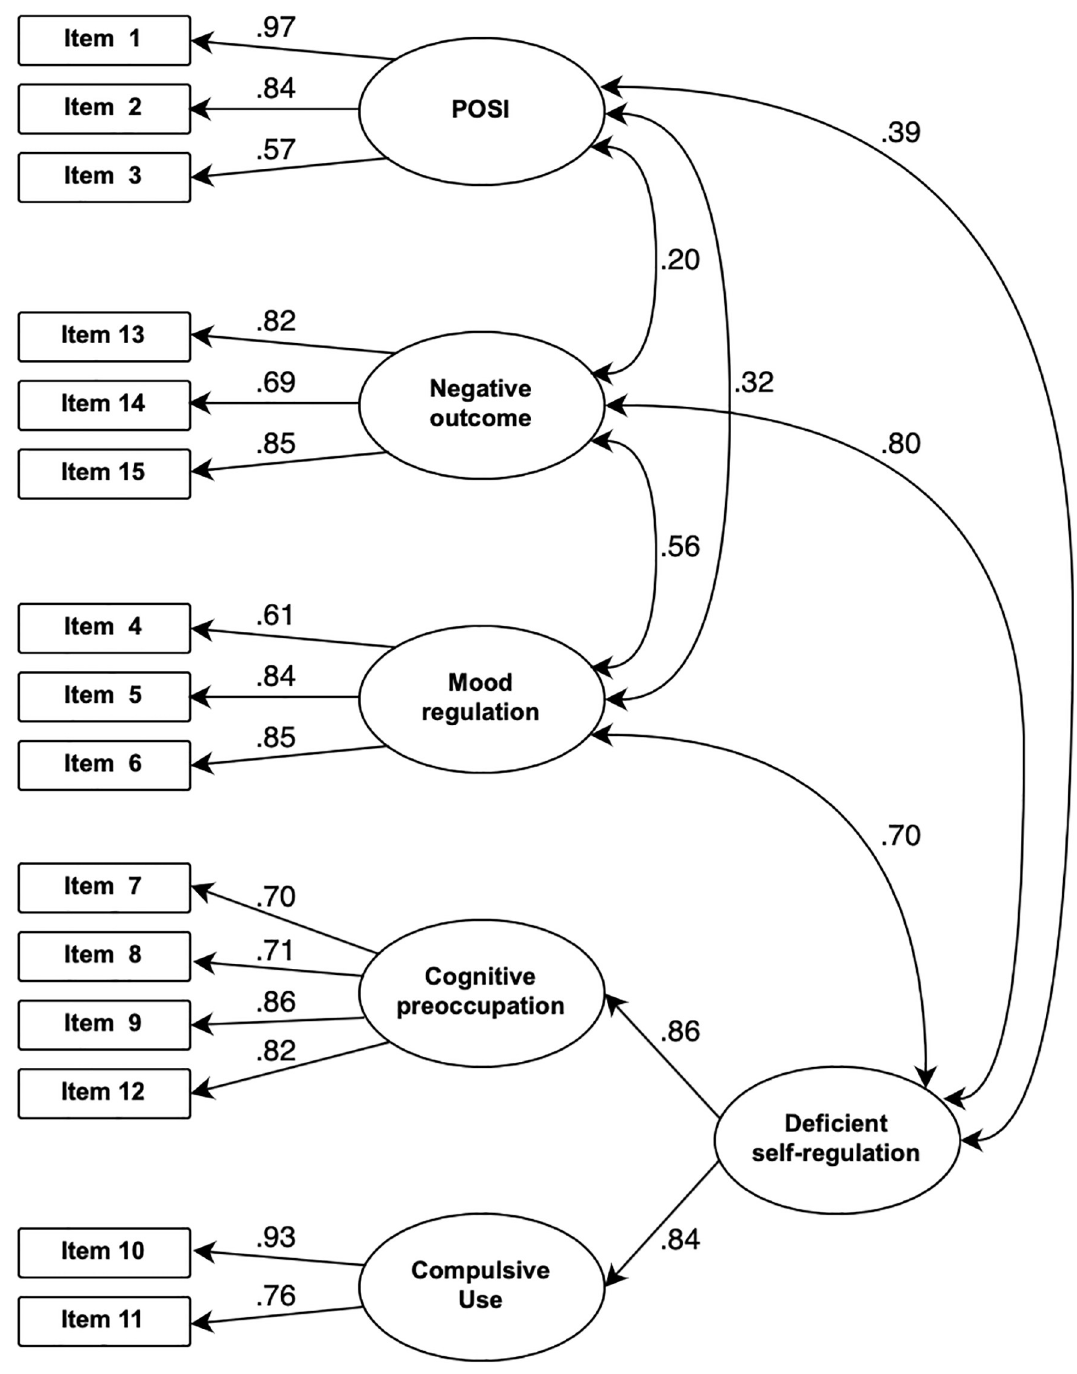
Fig 3. Confirmatory factor analysis for the Japanese model of